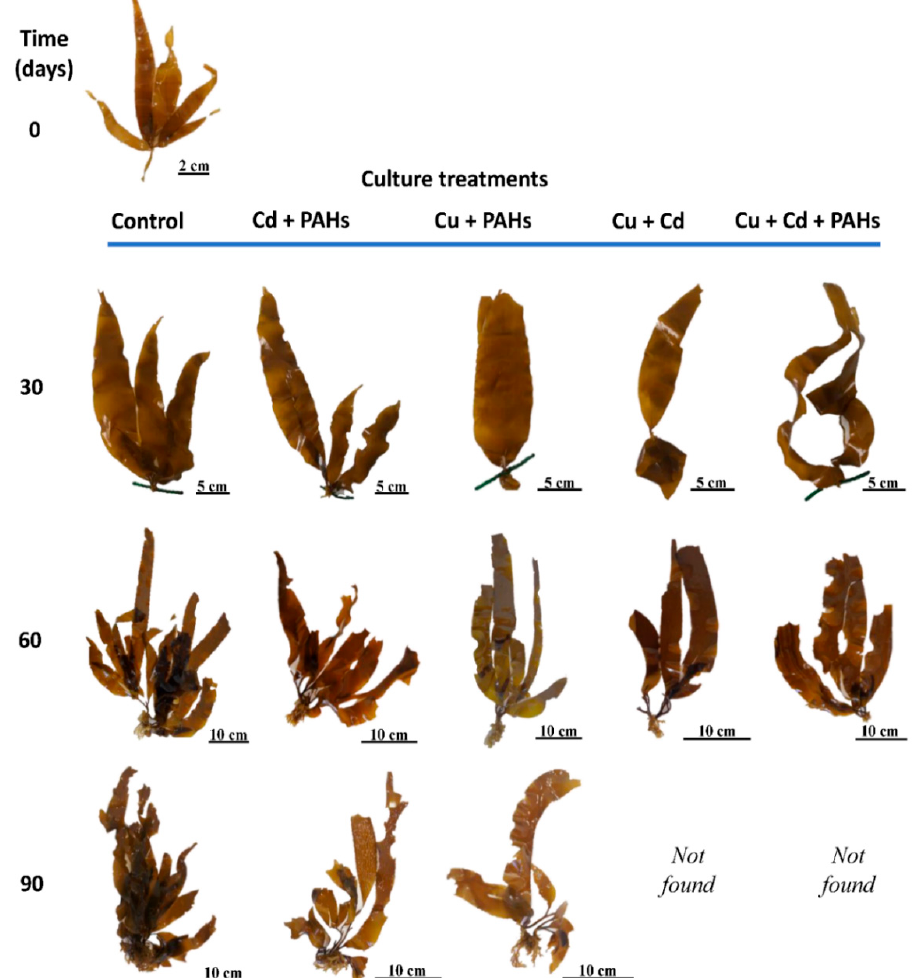
Figure 1. Representative images of Macrocystis pyrifera sporophyte from the control and from the heavy metal + PAHs treatments throughout the experimental period. Individuals from the treatments Cu + Cd and Cu + Cd + PAHs were not found at 90 days of culture.